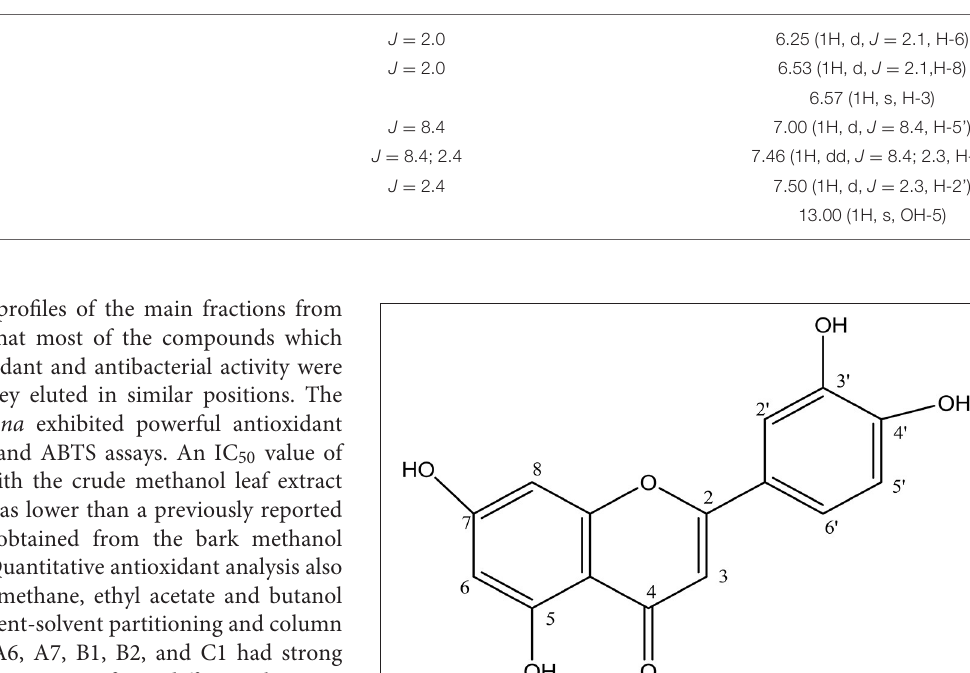
TABLE 6 | The 1 H NMR spectral data of luteolin isolated from S. singueana . Compound 1 H NMR (acetone-d 6 , 400 MHz)